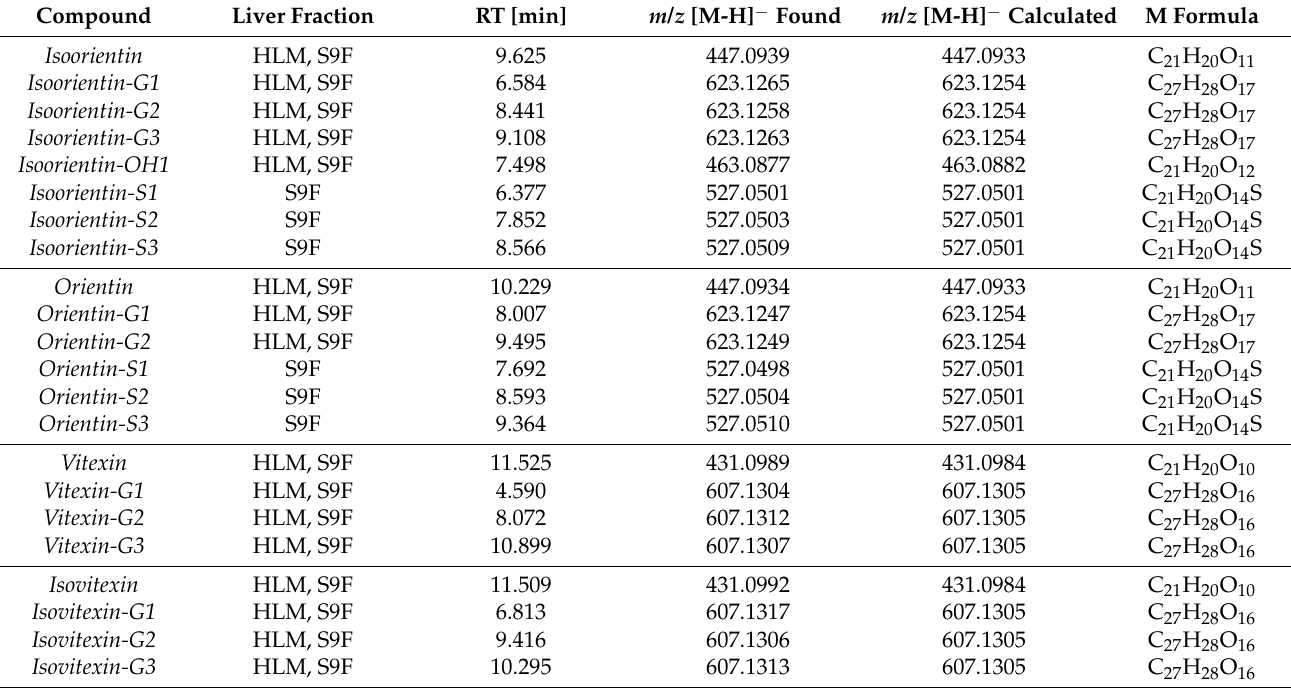
Table 1. IO, O, V, IV, and their metabolites formed by human liver microsomes and liver S9 fraction analyzed by LC–MS. HLM: human liver microsomes; S9F: liver S9 fraction; G: glucuronide; S: